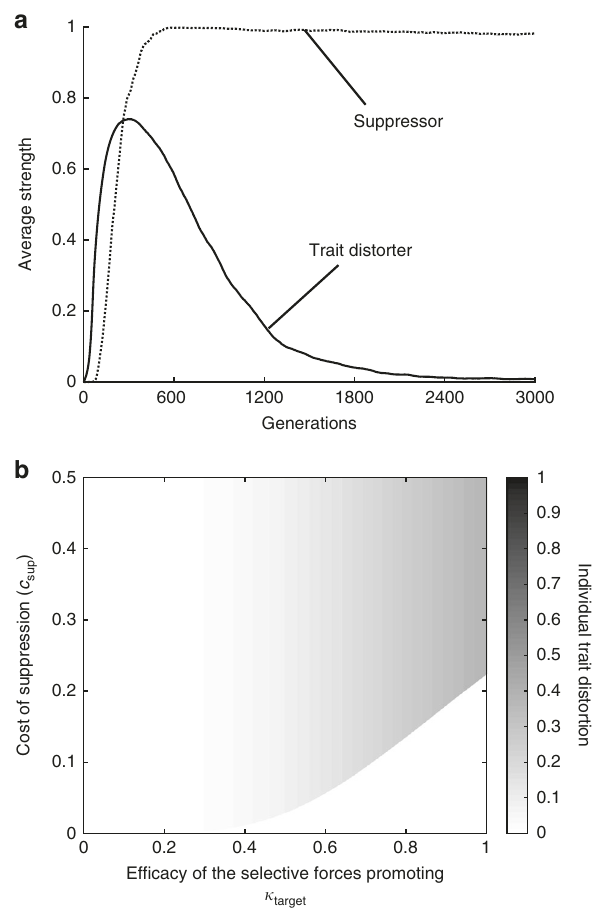
Efficacy of the selective forces promoting (cid:2) target Fig. 2 Evolution of trait distortion. In a , a trait distorter and suppressor are introduced in our agent-based simulation model (Methods: ‘ Agent-based simulation (single trait distorter locus) ’ ), with c sup = 0.1, t = k and c trait = max ( k a ,k b ) /2 . The population average trait distorter and suppressor strengths over 100 simulation runs are plotted for successive generations. Initially, both trait distorter and suppressor strength increases, but then the trait distorters are purged from the population. b shows how the trait distortion at equilibrium is in fl uenced by the cost of suppression ( c sup ), and the target level of trait distortion ( k target ), which is determined by the rate of increase in (cid:4) the marginal individual cost of trait distortion d 2 c trait d k 2